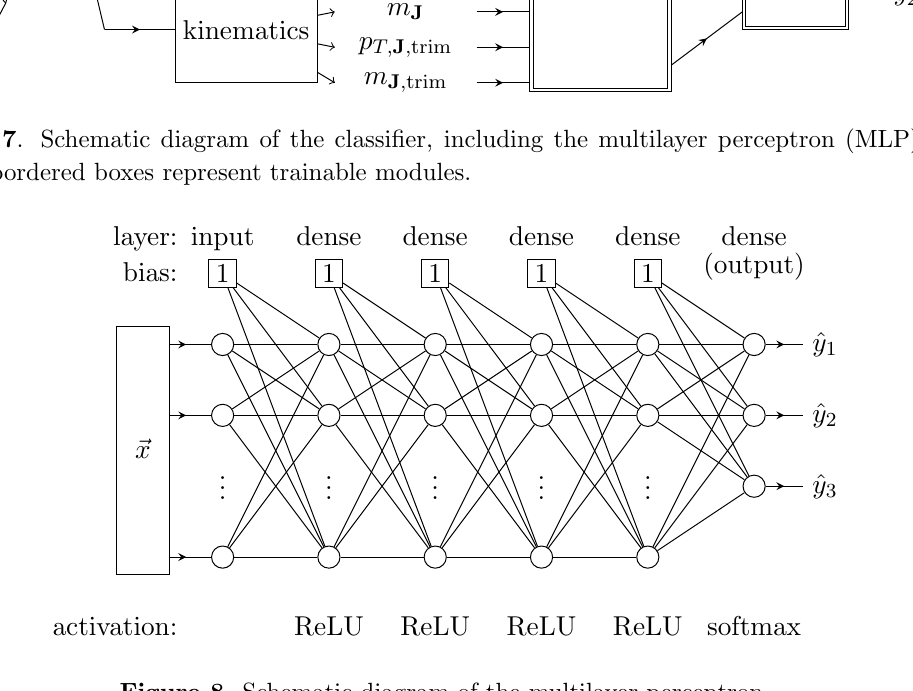
Figure 8 . Schematic diagram of the multilayer